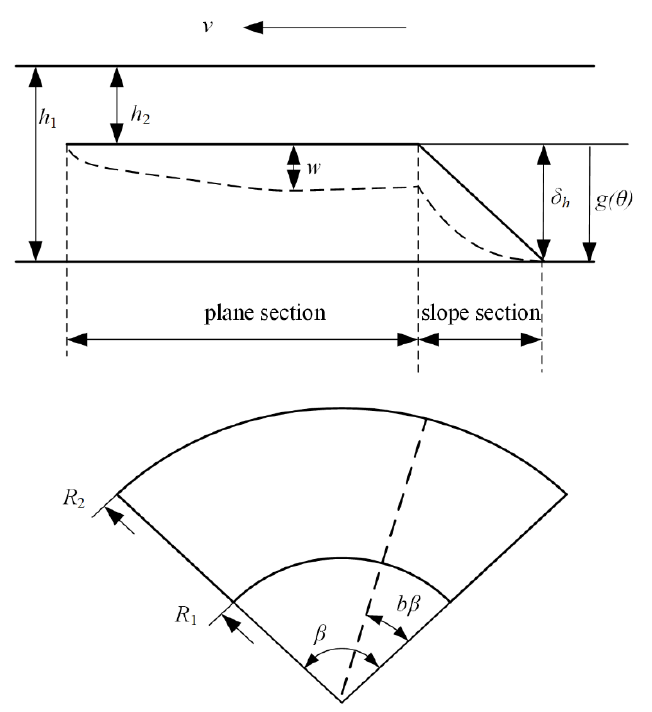
Figure 3. Gas film thickness distribution diagram.